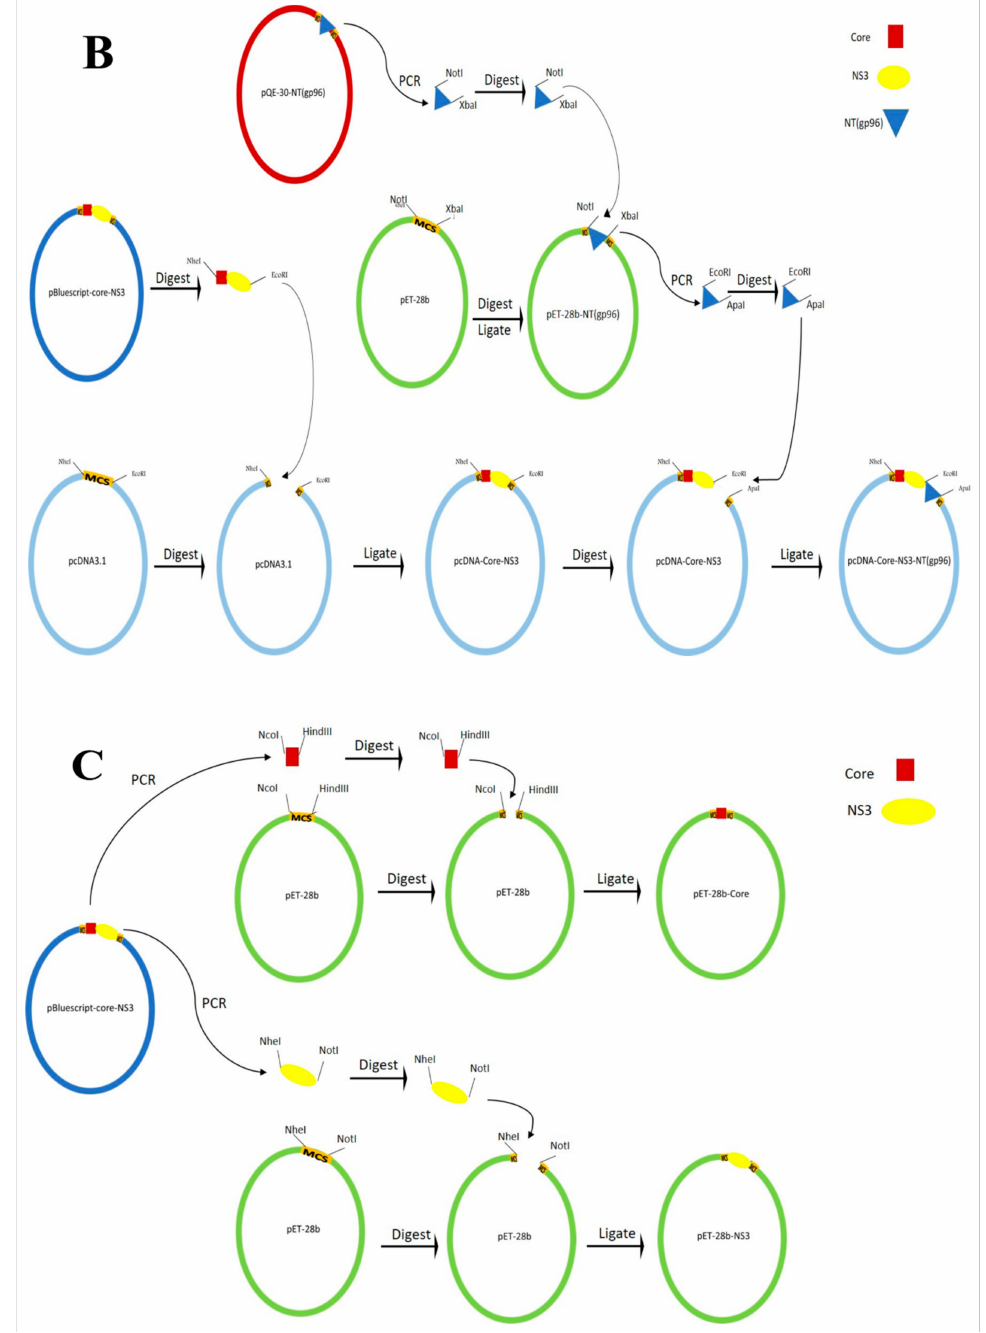
Figure 1. Schematic representation for the construction of the vectors. ( A ) pEGFP-Core-NS3-NT (gp96), ( B ) pcDNA-Core-NS3, pcDNA-Core-NS3-NT (gp96), and ( C ) pET-28b-Core,